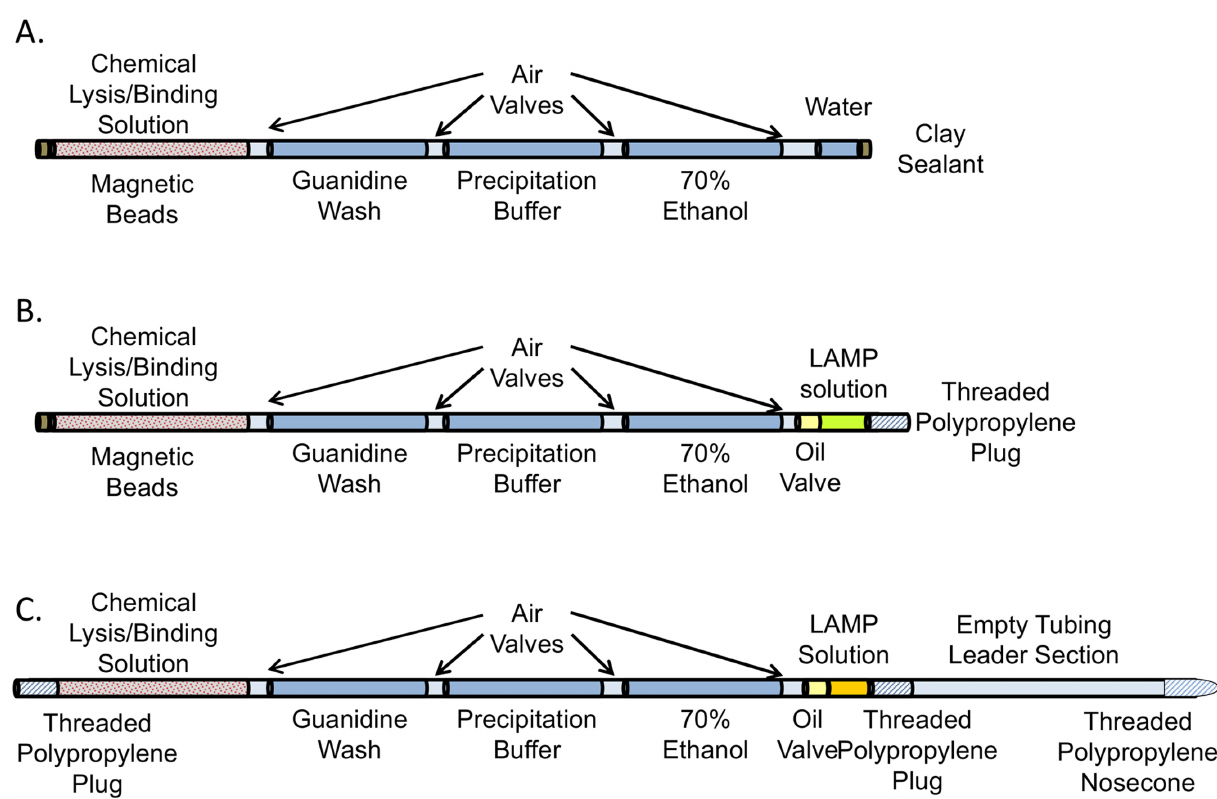
Fig 1. Low-resource DNA extraction technique. A. Lysed PATH samples were loaded into the extraction tubing as the first chamber. An external magnet was used to pull the binding beads through the solutions, and the DNA was eluted in the final chamber. B. Low-resource DNA extraction was combined with in-tube amplification. After the lysed sputum sample was introduced into the tubing, an oil valve was added to the opposite end to prevent evaporation of the LAMP reaction solution that followed. C. The tubing for automated DNA extraction and amplification is the same as the tubing in B with the addition of a leader section that guided the tubing through the instrument during the assay, as shown in Fig 2 and SI1.